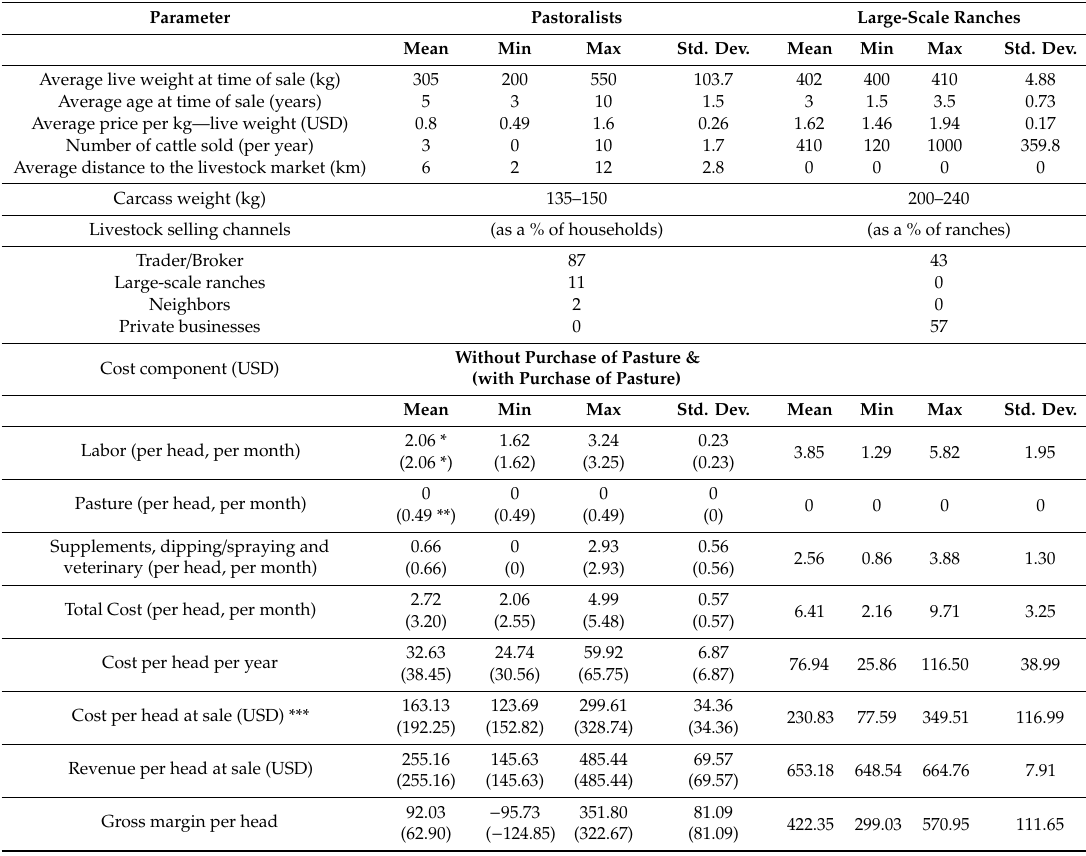
Table 2. Revenues, costs and gross margins for pastoralists and large-scale